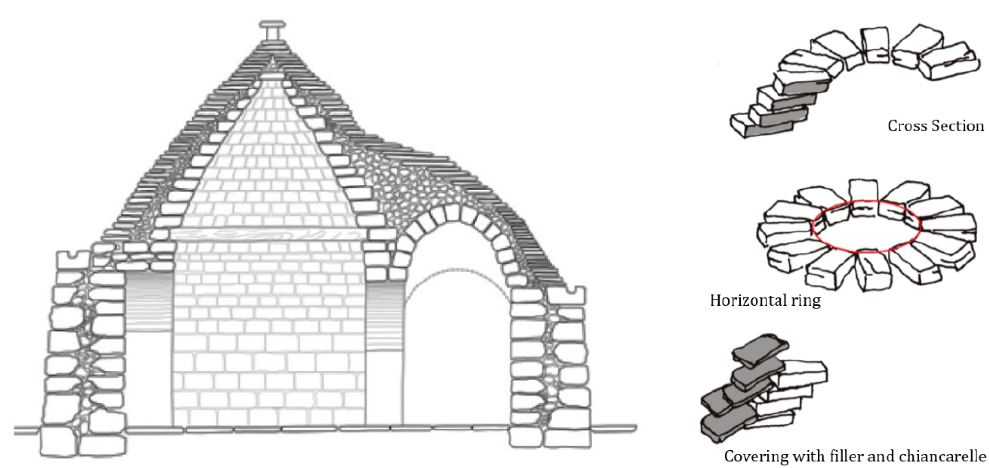
Figure 2: Constructive section and detail of an Italian Trullo